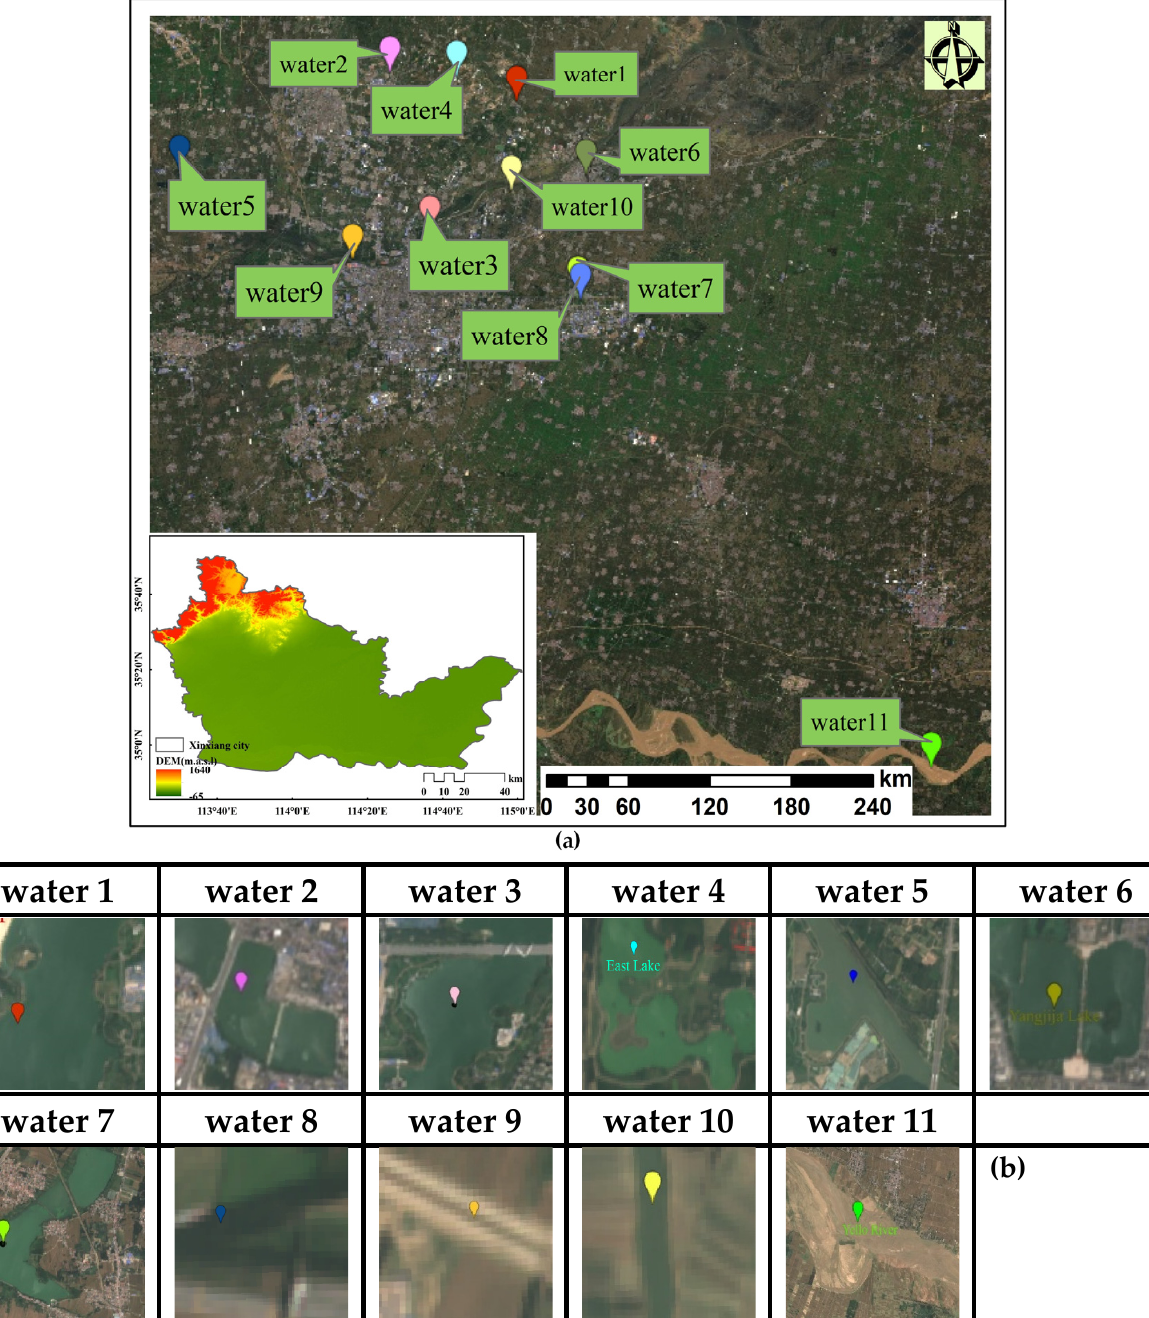
Figure 1. Sample region and respective Sentinel − 2A image samples: ( a ) Xinxiang city area, Henan Province, China, with marked Sentinel − 2A image sample region; ( b ) Sentinel − 2A images of water body samples 1 to 11. Color tags in each imagery mark the location where reflectance values were taken in the satellite imagery using 3 × 3 matrices except for small rivers.